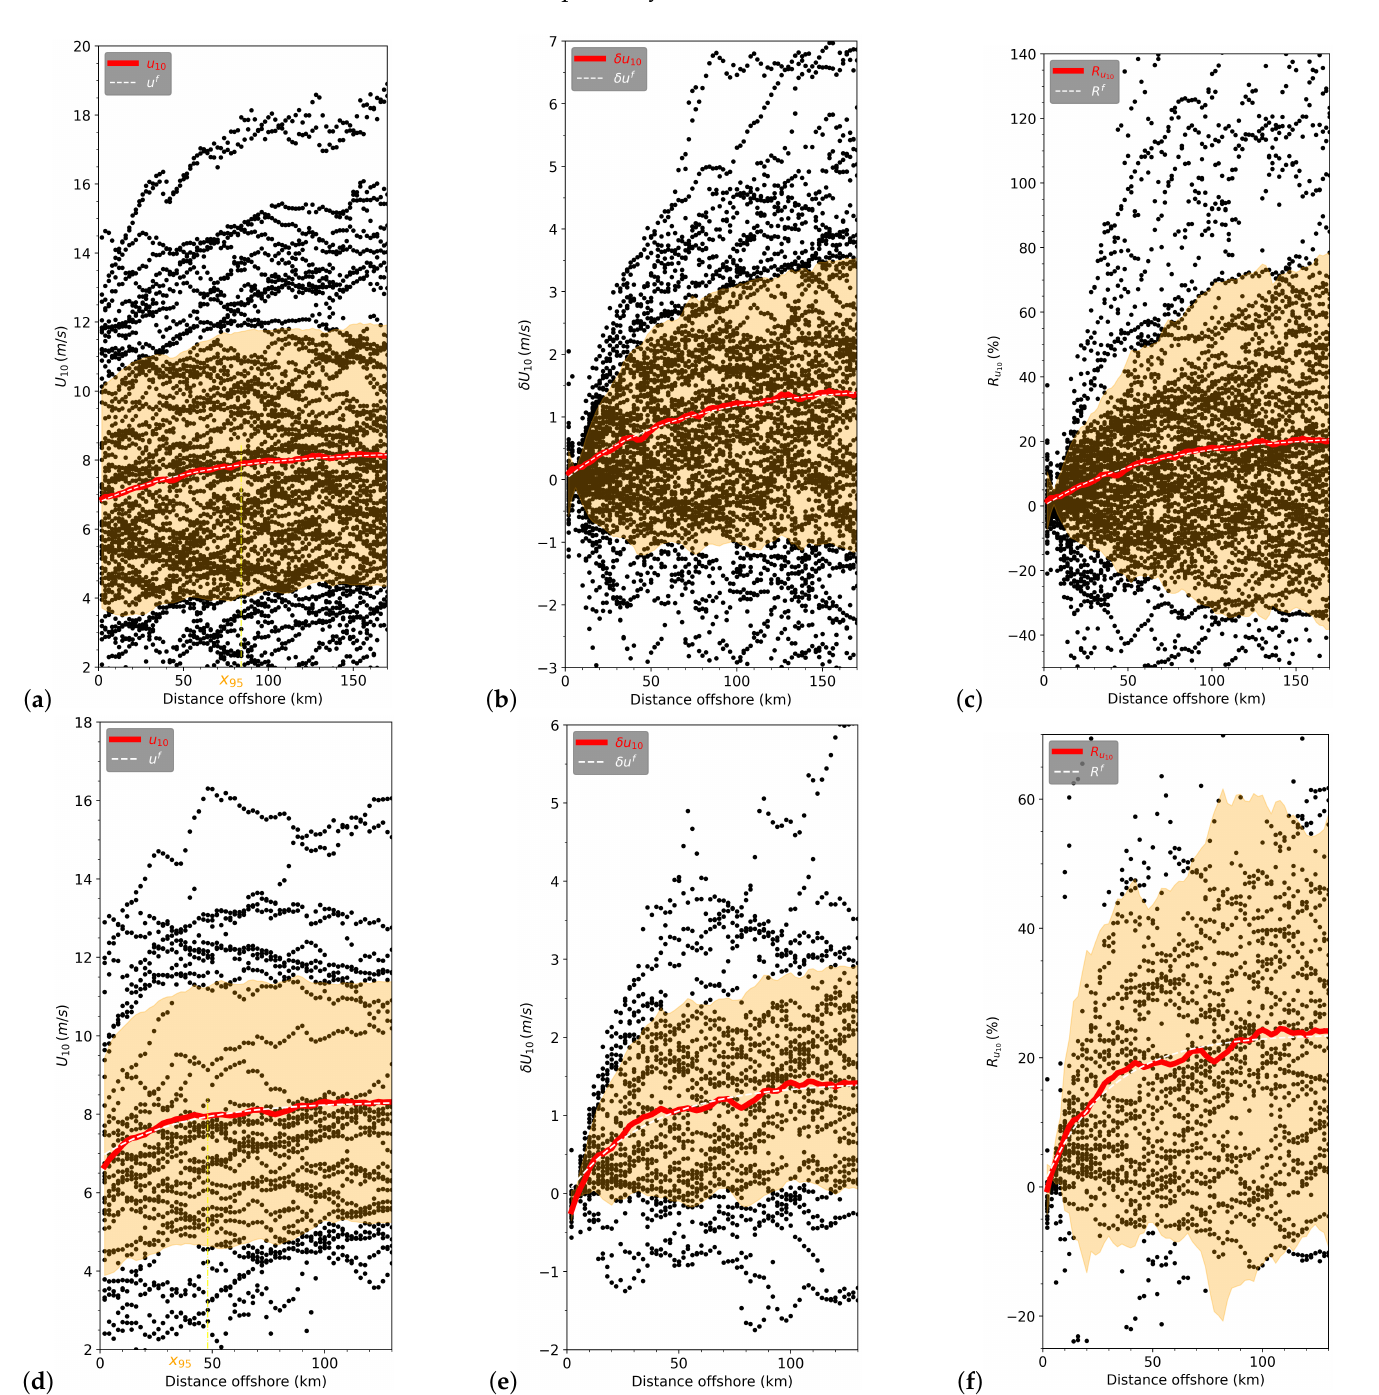
(yellow dotted line) indicates increases of the parameters ∆ u , R f max , x 95% of about 1.5 m/s, 22% and 84 km, respectively.